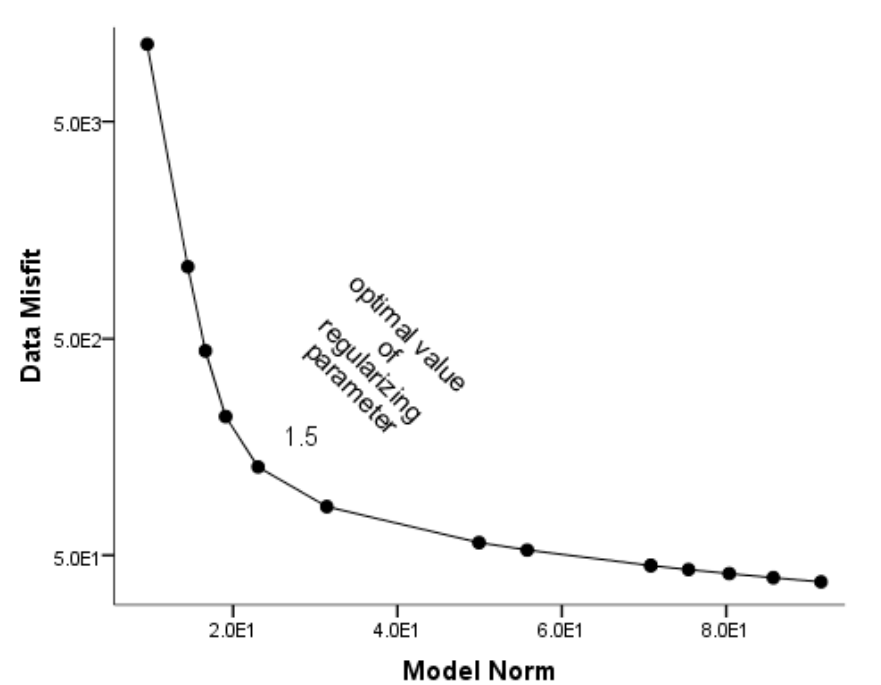
Figure 3. L_curve solution for data misfit ( φ d ) against model objective function ( φ m ). The plot, called the L_curve method, indicates the optimal value of regularization parameter as a value that lies at the corner of the L_curve.